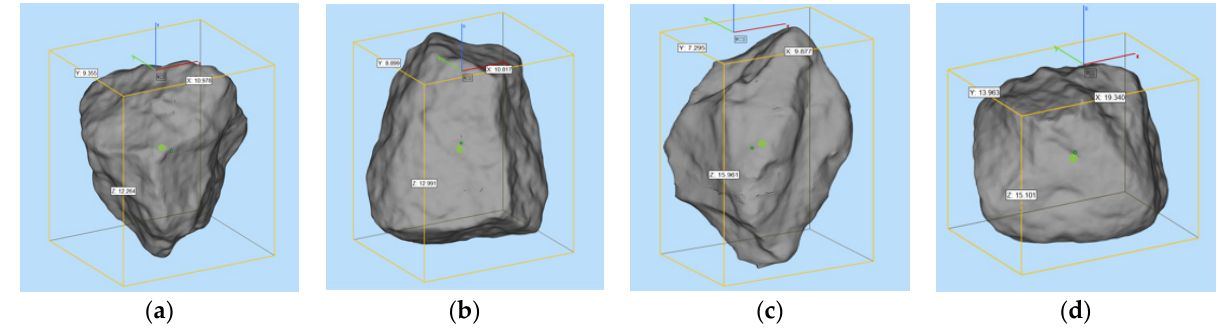
Figure 14. 3D scanning results of natural aggregates ( a – d are random samples).